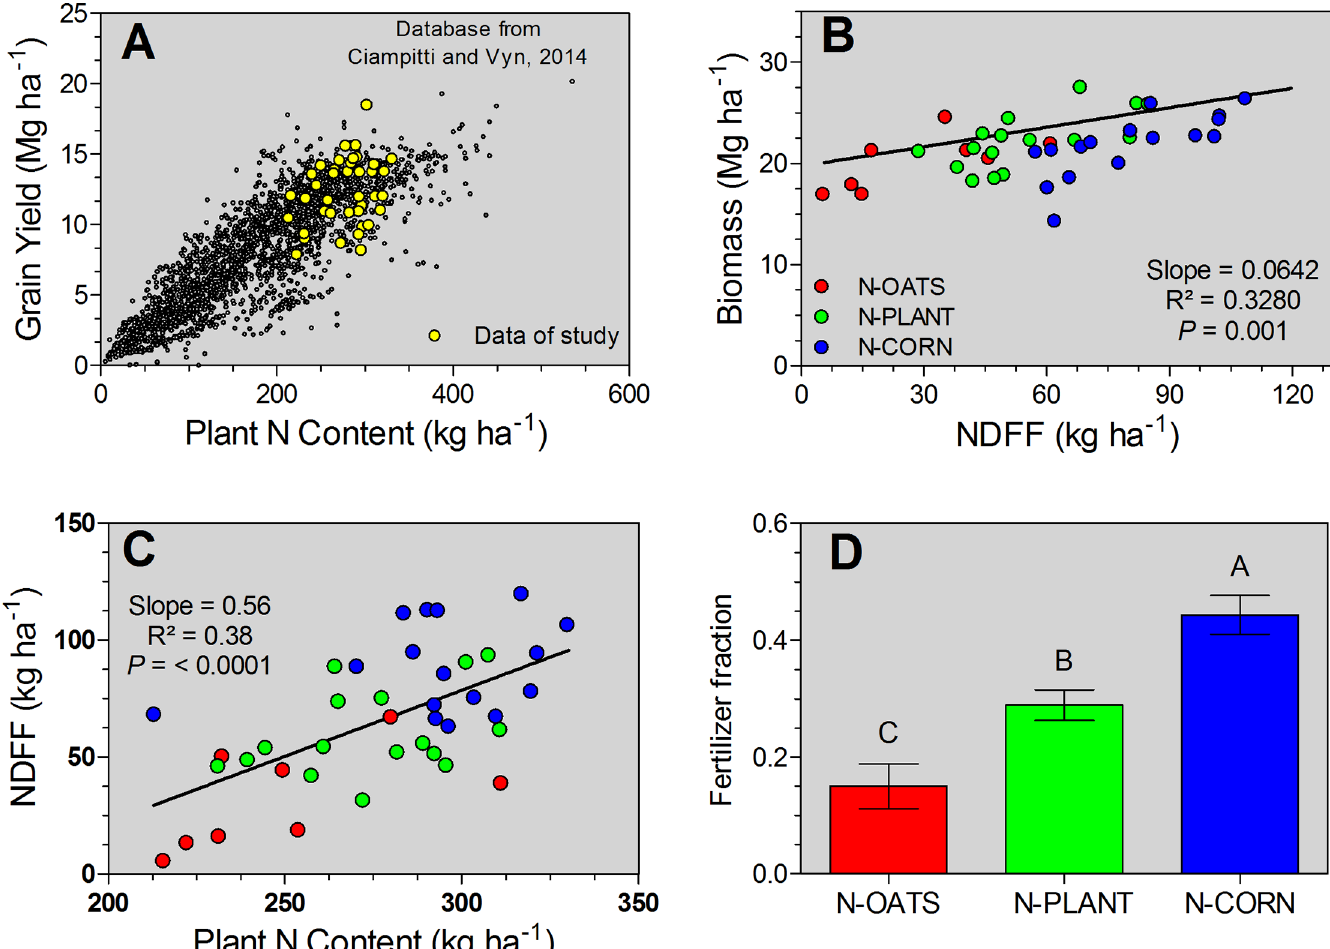
Fig 4. Relationship between grain yield and plant N content (A), biomass and NDFF (B), and NDFF, plant N content (C), and the overall fertilizer fraction on plant N content for the fertilizer N timing groups: fertilizer N applied to oats (N-OATS, red color; n = 8), N applied at pre-plant and at planting time for corn (N-PLANT, green color; n = 16), and in-season N added at V3 and V3/V6 growth stages for corn (N-CORN, blue color; n = 16).